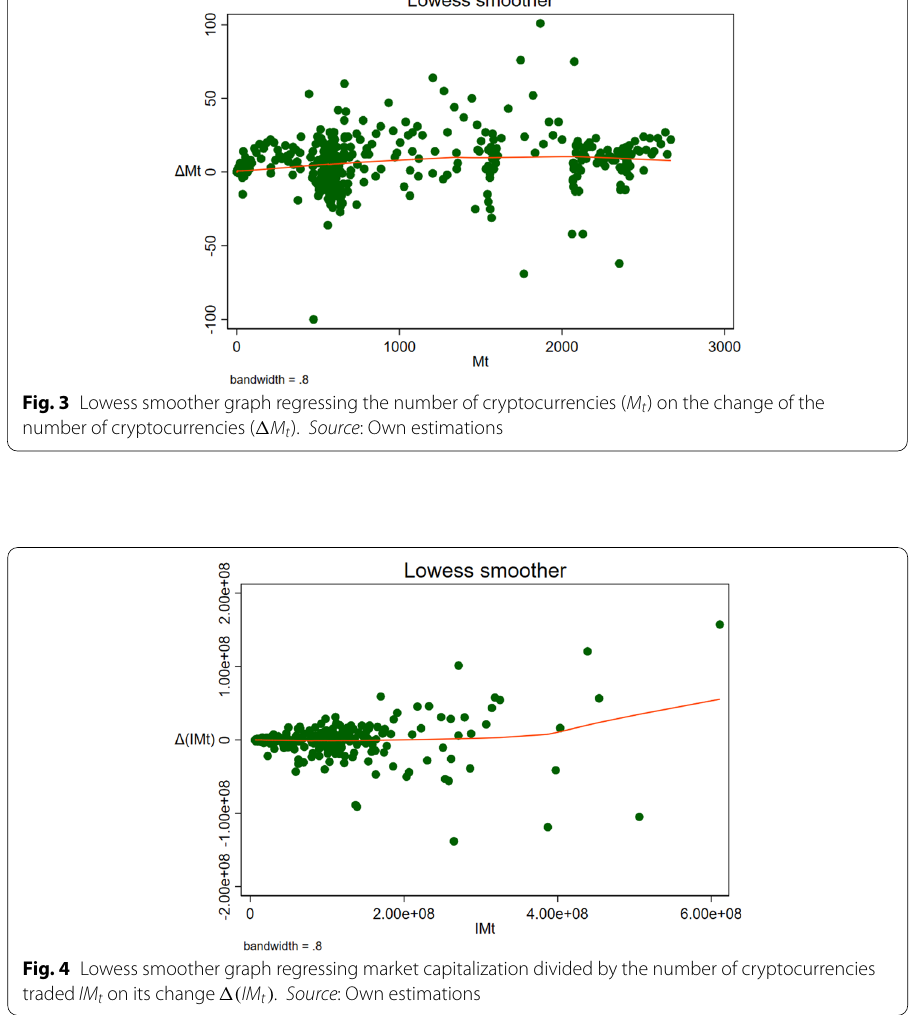
a where and β are the estimable parameters and Furthermore, our prior compatible with the self-gravitational property is that β > Therefore, the testable hypothesis is formulated as H 0 : β = 0,